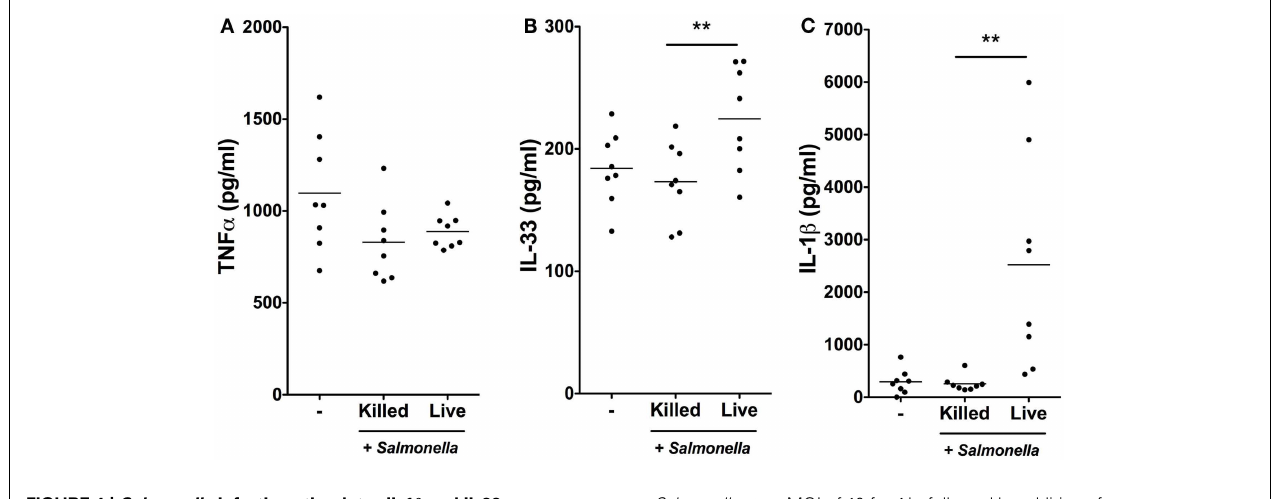
FIGURE 4 | Salmonella infection stimulates IL-1 β and IL-33 production by iSCs . (A–C) show production levels of the indicated cytokines over a 24h period by iSCs, determined by ELISA. iSCs were left unstimulated ( − ) or exposed to live or heat-killed